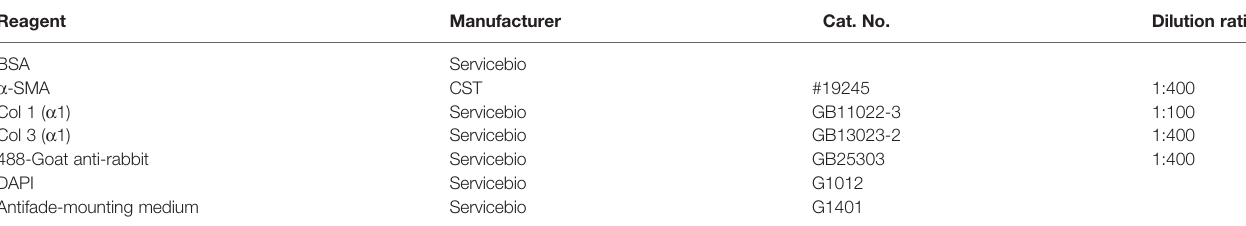
TABLE 2 | Information for immuno fl uorescence antibodies and other reagents.